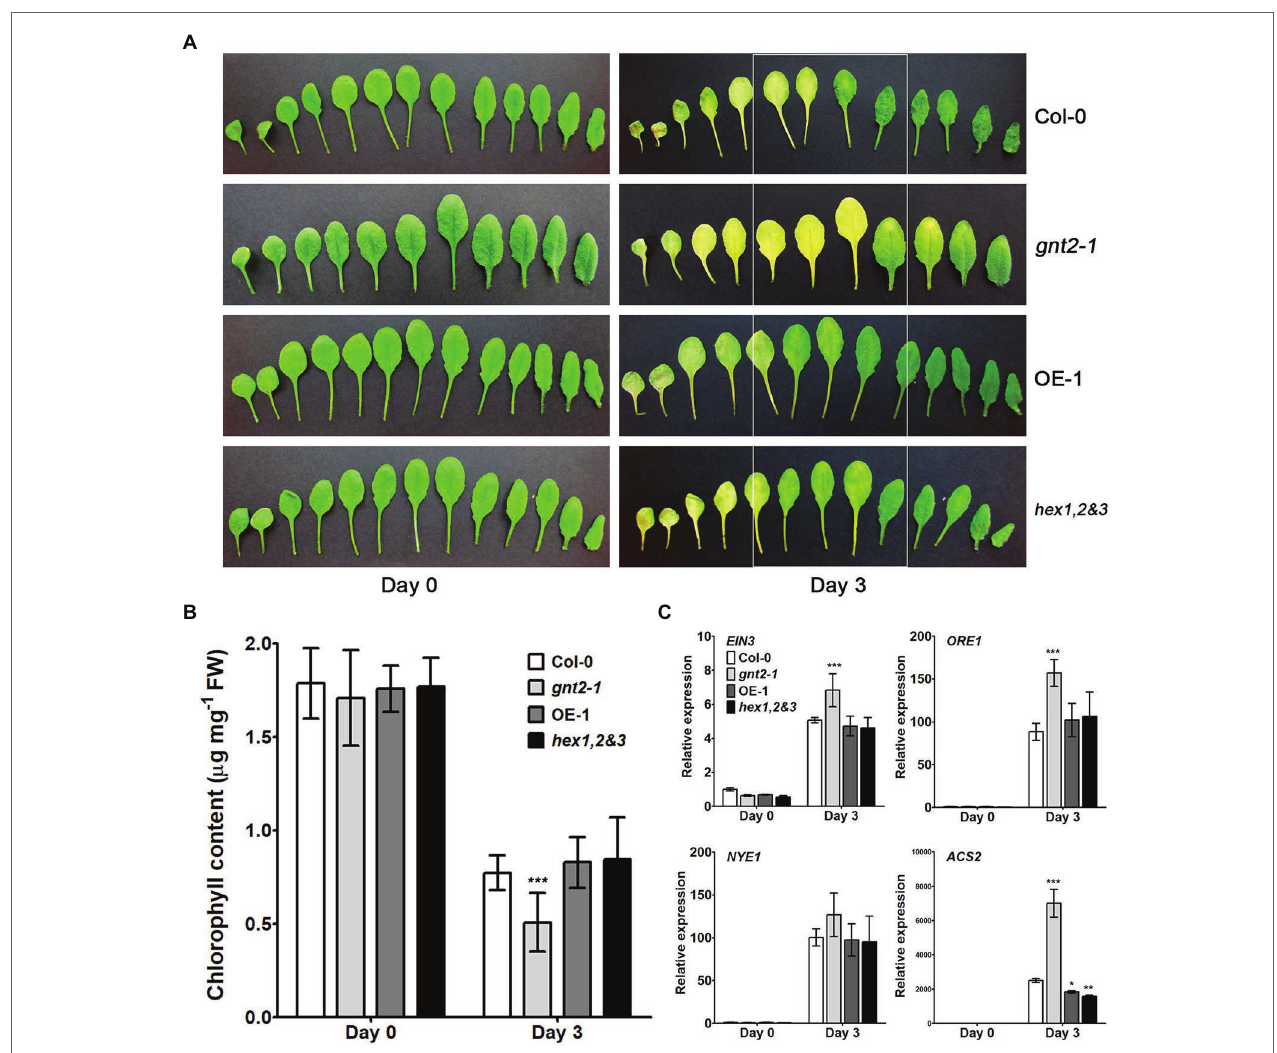
FIGURE 4 | GnTII is involved in dark-induced leaf senescence. (A) Phenotypes of leaves from 4-week-old (0-day) Col-0, gnt2-1 , OE-1, and hex1,2&3 plants. Senescence symptoms of detached leaves from the Col-0, gnt2-1 , OE-1, and hex1,2&3 plants after 3 day of dark treatment. The leaves are arranged from oldest (left) to youngest (right). (B) Chlorophyll contents of Col-0, gnt2-1 , OE-1, and hex1,2&3 plants. Chlorophyll content was determined in leaves from 4-week-old (0- day) plants and leaves following a 3-day dark treatment. (C) Relative expression of the senescence-related genes EIN3 , ORE1 , NYE1 , and ACS2 in leaves from the Col-0, gnt2-1 , OE-1, and hex1,2&3 plants analyzed by qPCR. Total RNA was extracted from 4-week-old plants before and after 3 day of dark treatment. The experiment was performed independently three times (three biological replicates) and normalized with respect to β -TUBULIN expression. Data represent mean ± SEM of three independent experiments. Asterisks indicate statistically significant differences (* p < 0.05, ** p < 0.01, and *** p < 0.001) as determined by two- way